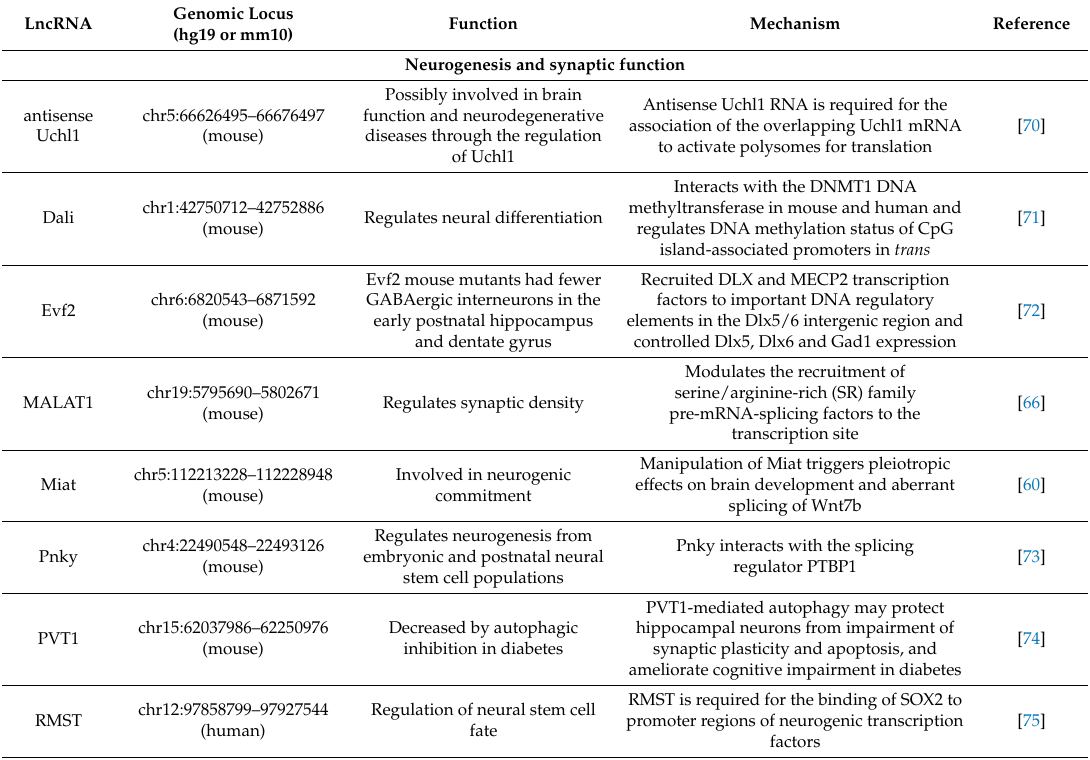
Table 1. List of lncRNAs related to neurogenesis and synaptic function, A β accumulation, immune response, insulin signaling and glucose homeostasis. Only those with known mechanisms were selected. The genomic loci of lncRNAs are shown based on the genomic coordinates at hg19 genome assembly for humans or at mm10 assembly for mice,